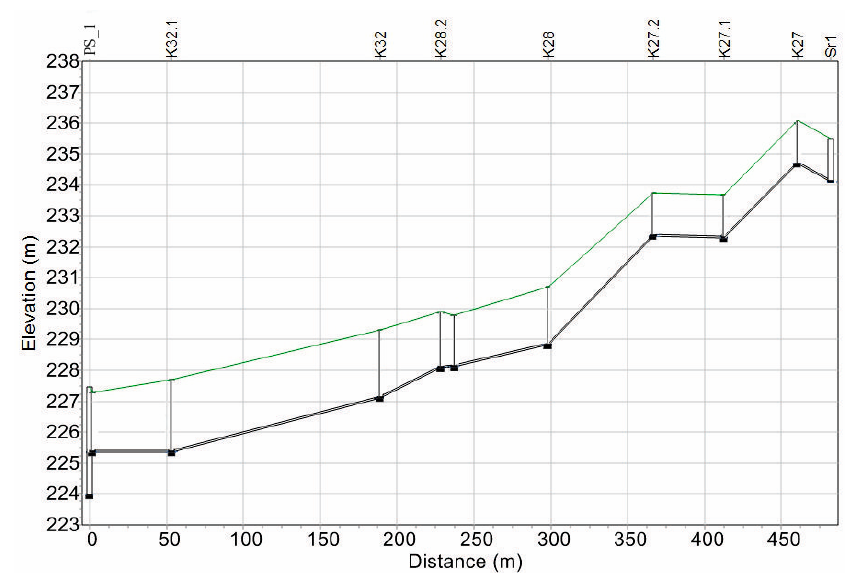
Figure 2. Profile of small diameter gravity sewerage system between pumping stations PS_2 and PS_1.